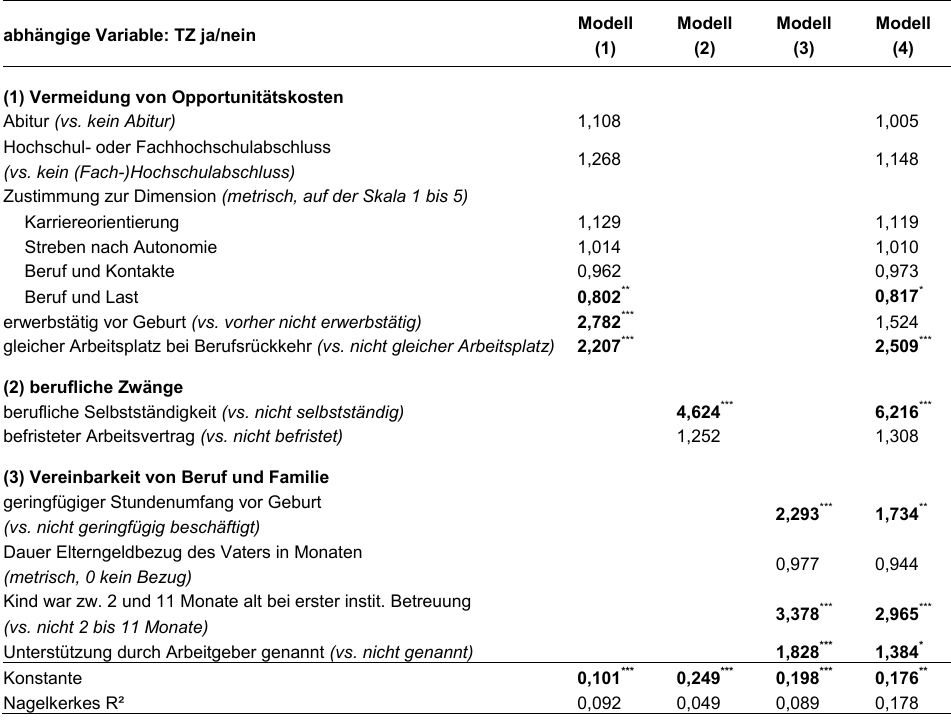
Tabelle 4 : Binär-logistische Regression für Teilzeiterwerbstätigkeit (TZ) während des Bezugs von Elterngeld